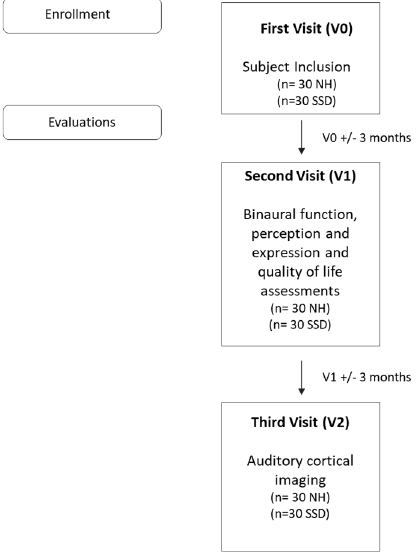
Figure 2. Auditory stimulation blocks and conditions.